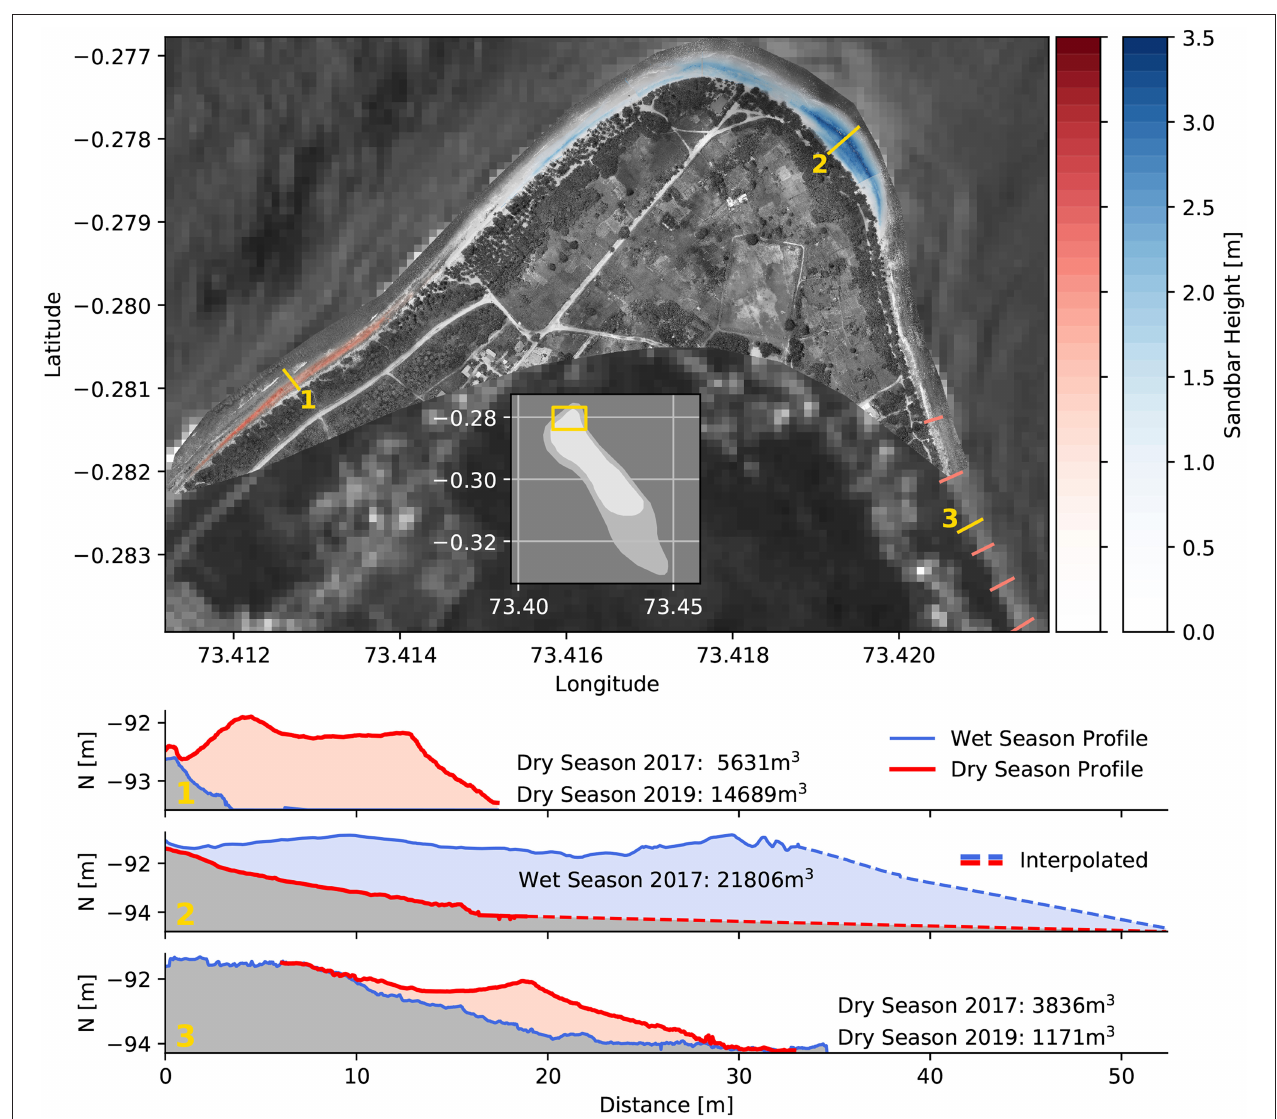
FIGURE 4 | Location of sediment volumes and profiles (orange lines) for the dry season 2017 (red colorbar) and wet season 2017 (blue colorbar) in the north of Fuvahmulah. In the dry season sand depots form at the adjacent beaches Geiymiskih Fannu in the west (profile 1) and Thoondu in the east (profile 3) of the headland. The wet season allocates sand on the north tip of the island, forming the Thoondu sand pit (profile 2). The dry season sand volume of eastern Thoondu beach (profile 3) was integrated over differences of six accuracy-improved profiles. The profile elevation N is given as distance to the WGS84 ellipsoid. The background satellite image contains Copernicus Sentinel data (true color, red green blue) from September 14, 2017, which is in the wet season.